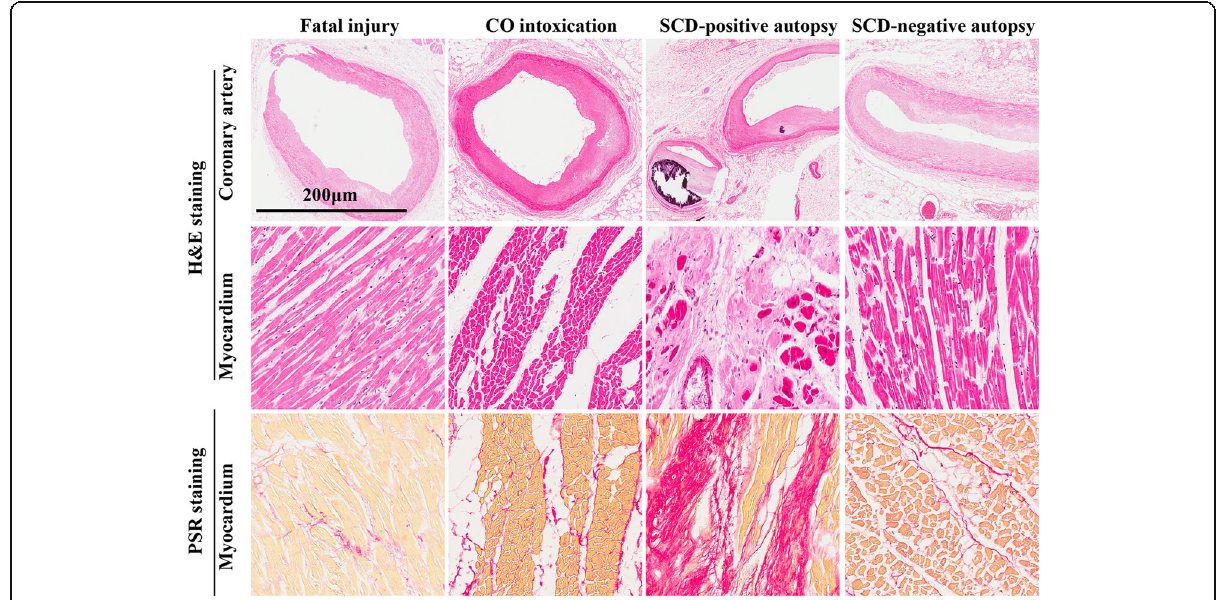
Fig. 1 Representative photographs of the morphological changes in the heart tissues of fatal injury, carbon monoxide (CO) intoxication, sudden cardiac death with positive autopsy (SCD-positive autopsy), and sudden cardiac death with negative autopsy (SCD-negative autopsy) by H&E staining and PicroSirius Red (PSR) staining. The SCD-positive autopsy group presented with severe coronary stenosis, calcification, and fibrotic tissue accumulation, whereas the fatal injury and CO intoxication groups did not show notable pathological changes. SCD-negative autopsy group showed slight histological changes such as interstitial edema, fiber rupture, and patchy hypereosinophilia of cardiomyocytes. Scale bar = 200 μ